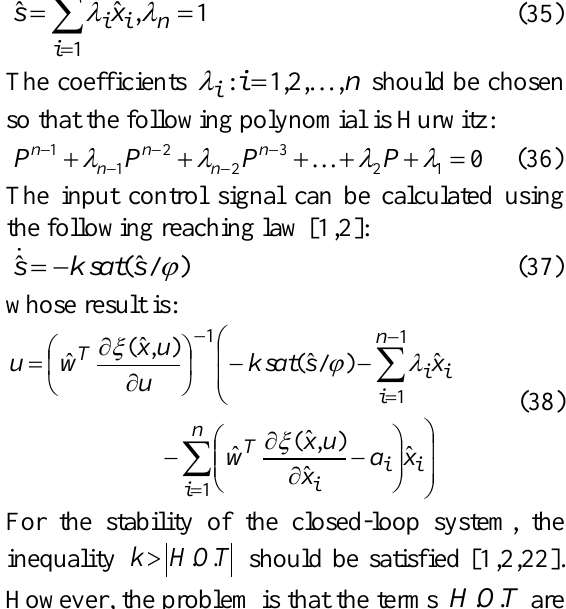
Figure 16. Input control signal of non-linear system.